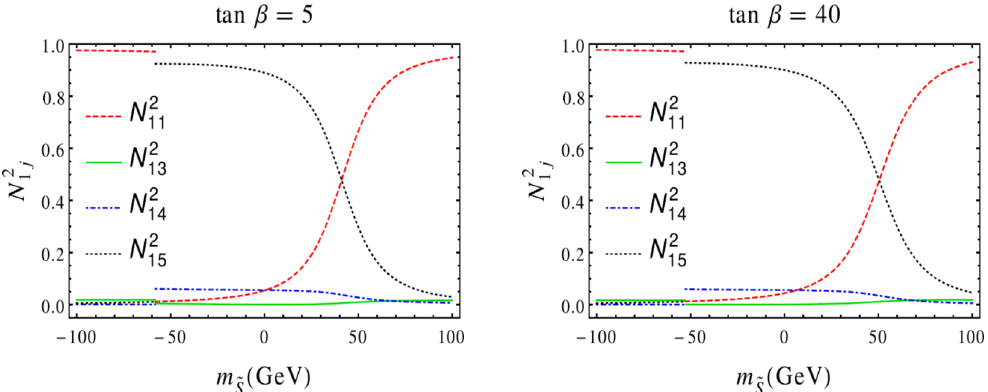
Figure 3 . Variations of various elements N 1 j of the matrix ‘ N ’ in eq. (2.18) representing the admixtures of bino ( j =1), higgsinos ( j =3,4) and singlino ( j =5) in the LSP as functions of m with e S flipping signs over the shown range and for fixed values of µ (= 350 GeV) and λ (= 0.5) and two eff fixed values of tan β (= 5 (left) and 40 (right)). With M set to a much larger value (2.5 TeV), the 2 wino admixture in the LSP ( N ) is negligible and hence 12